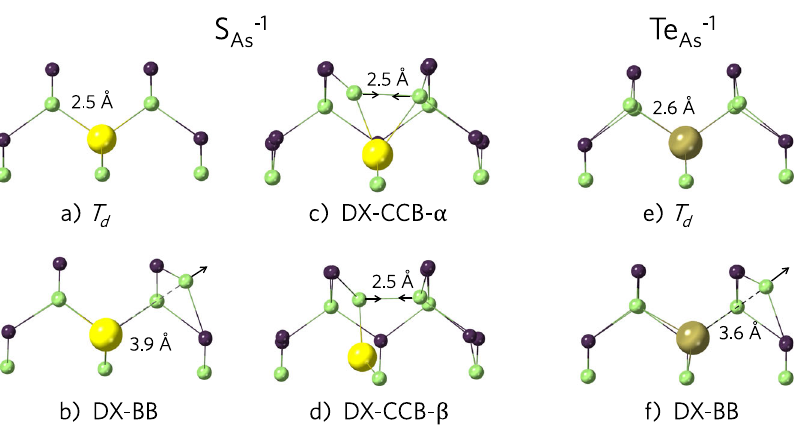
Fig. 8 Ground state ( T d ) and low-energy metastable con fi gurations (DX-BB, DX-CCB- α and DX-CCB- β ) identi fi ed for S (cid:1) 1 In the DX-BB con fi guration, a dopant-Ga bond is broken, while the DX-CCB con fi gurations correspond to cation-cation bond (CCB) formation. S in yellow, Te in gold, Ga in green and As in purple.